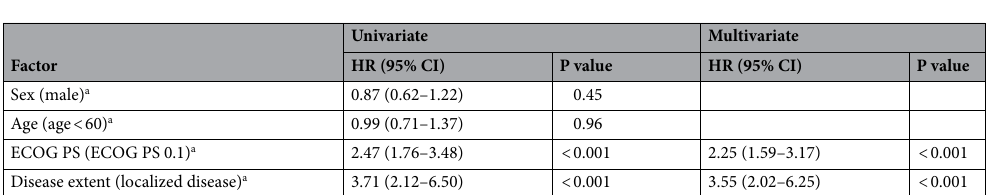
Table 5. Univariate and multivariate Cox-regression analyses of prognostic factors for overall survival in patients with CUP. CI confidence interval, HR hazard ratio, ECOG PS Eastern Cooperative Oncology Group Performance Status. a